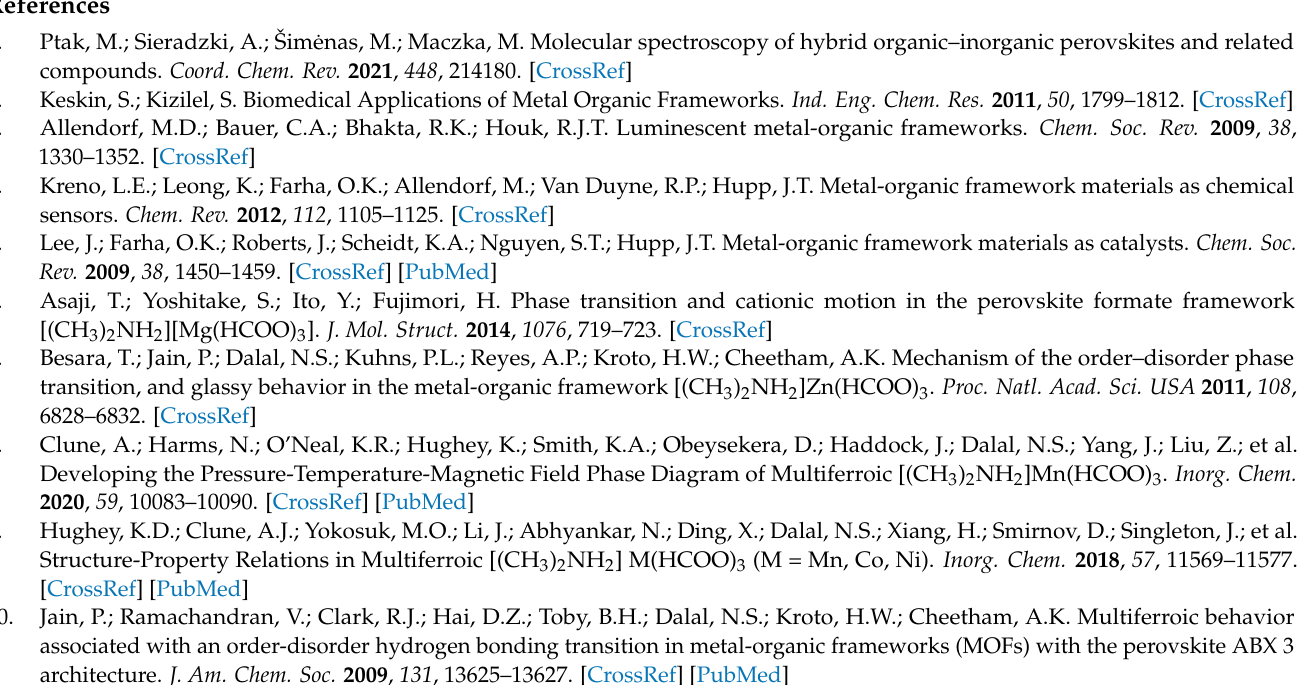
Figure S3: Thermal evolution of IR spectra measured for DMAZnD. Figure S4: A comparison of temperature dependencies of Raman and IR bands for DMAZnD and DMAZnF. Table S1: The wavenumbers along with intensity and proposed assignment of the observed IR and Raman bands at RT and at 80 K for